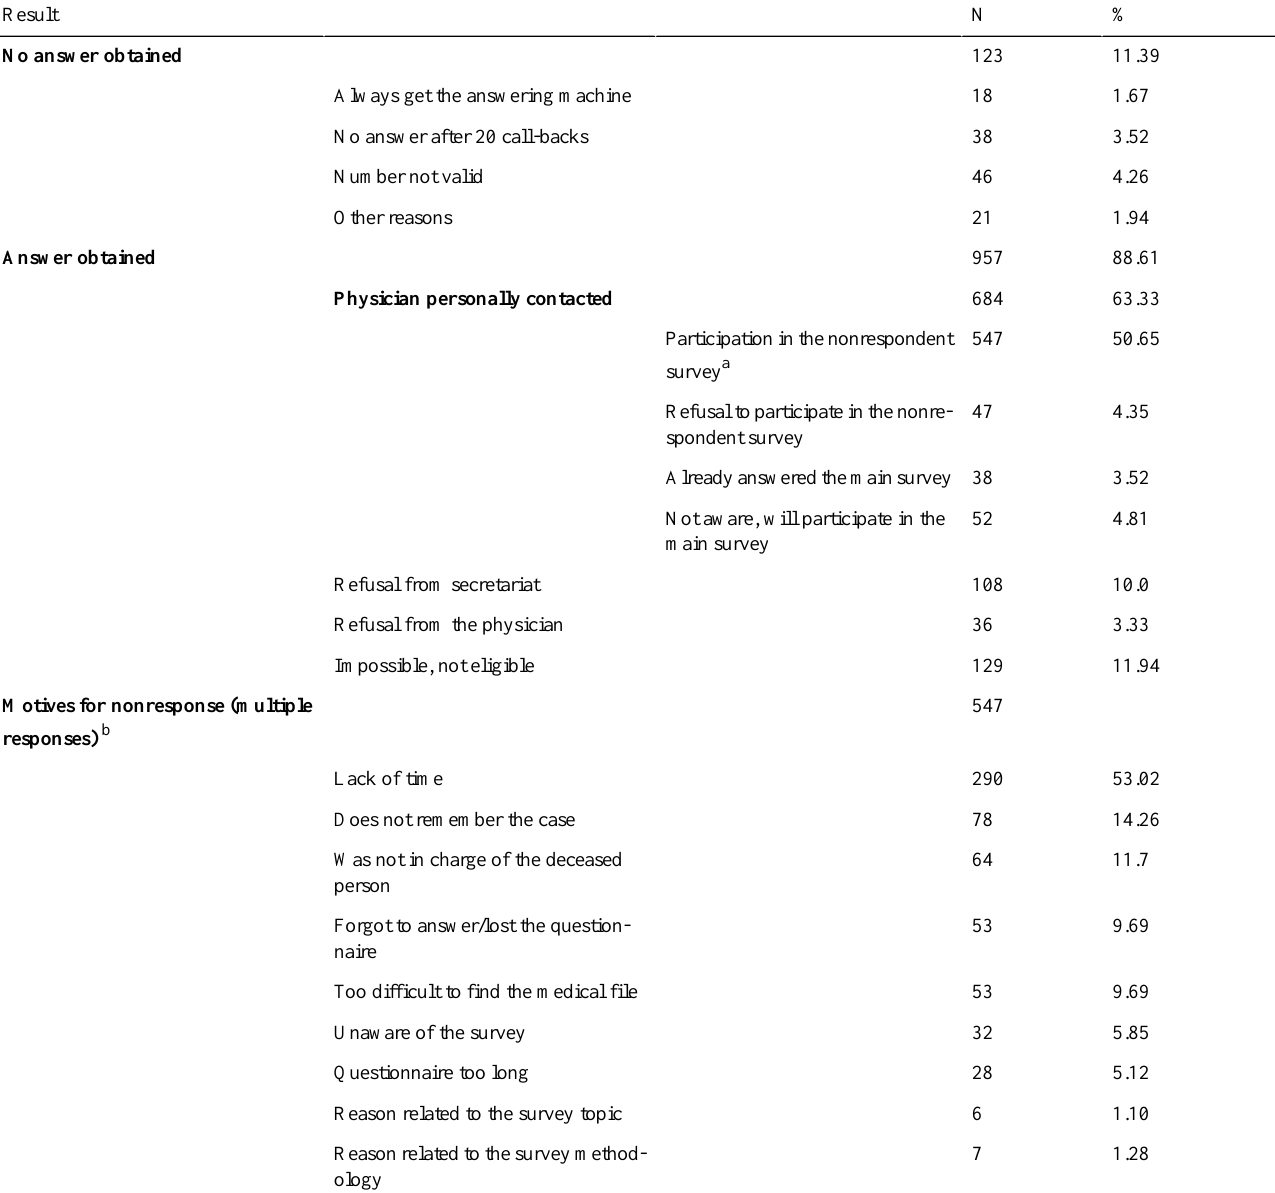
Table 4. Results of the telephone nonrespondent survey (third stage) and motives for nonresponse (N=1080).